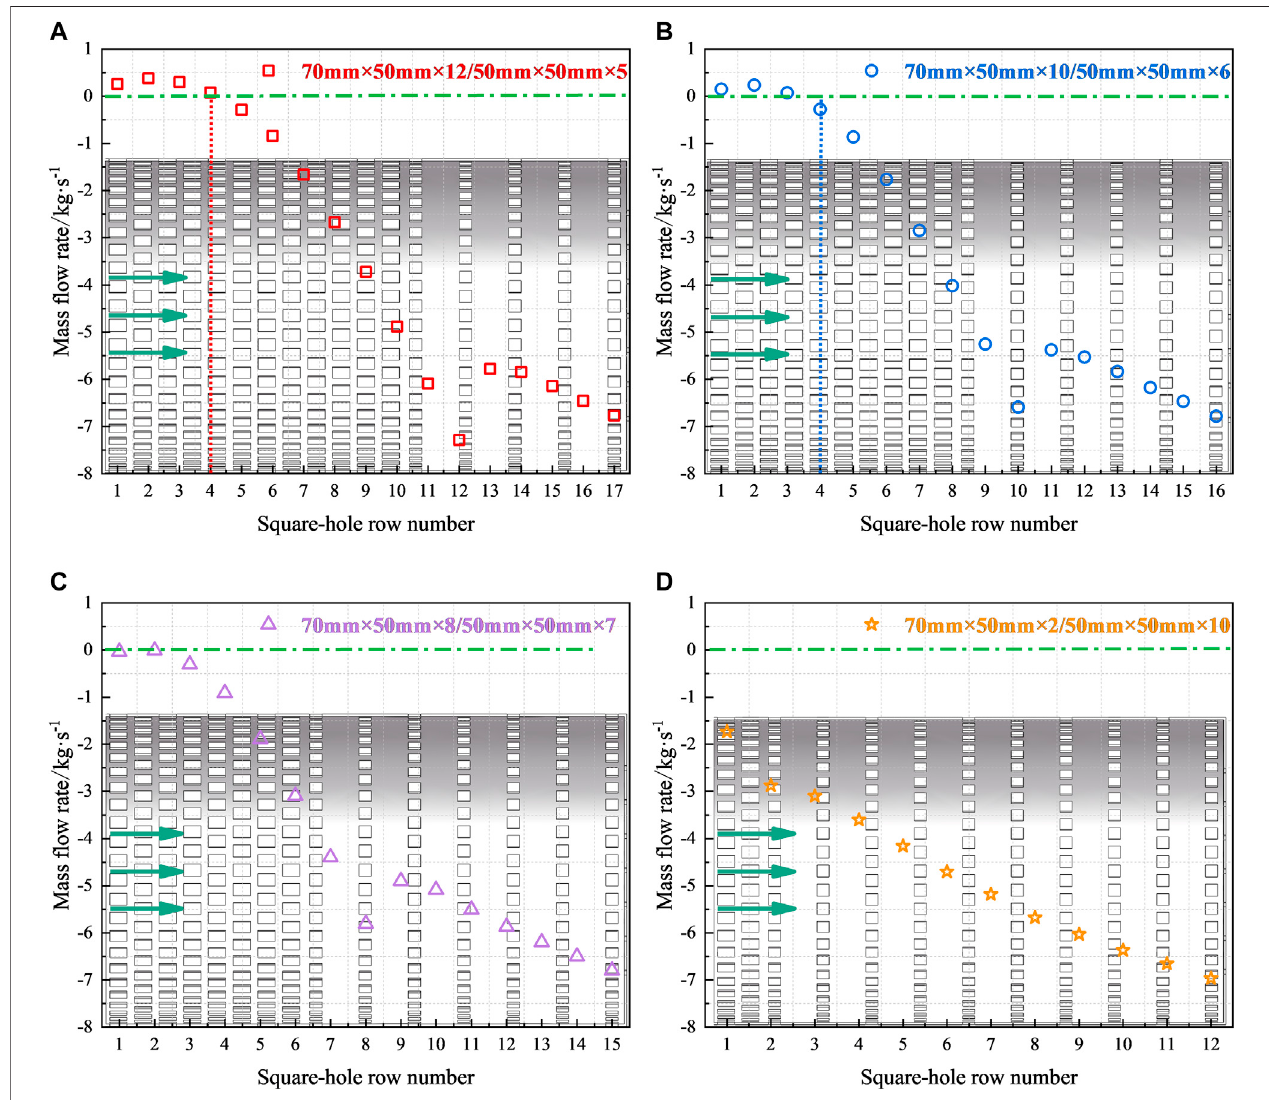
FIGURE 12 | Flow distribution characteristics of fl ow homogenizers with different square hole row numbers. (A) Flow homogenizer No.19. (B) Flow homogenizer No.12. (C) Flow homogenizer No.20. (D) Flow homogenizer No.23.